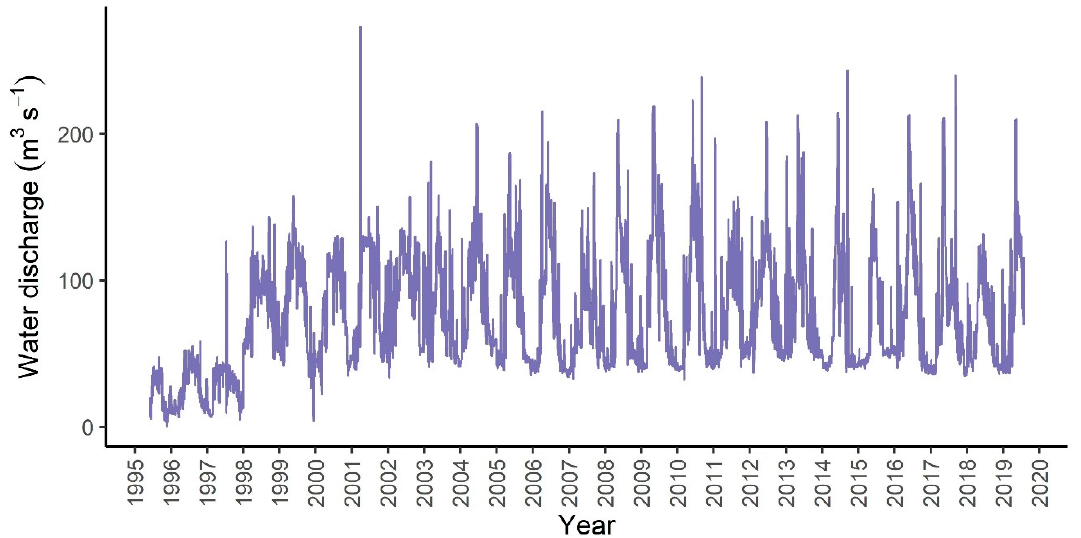
Figure A1. Discharge rates in the Cikola tributary system from 1995 to present.